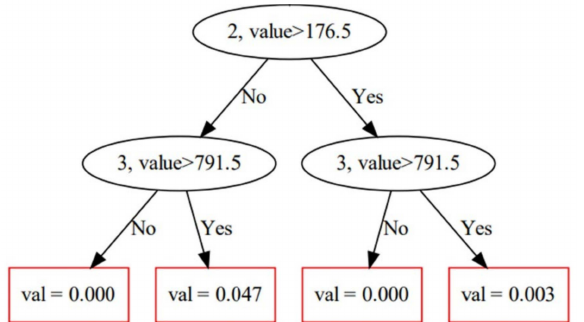
Figure 7. Visualization of the tree